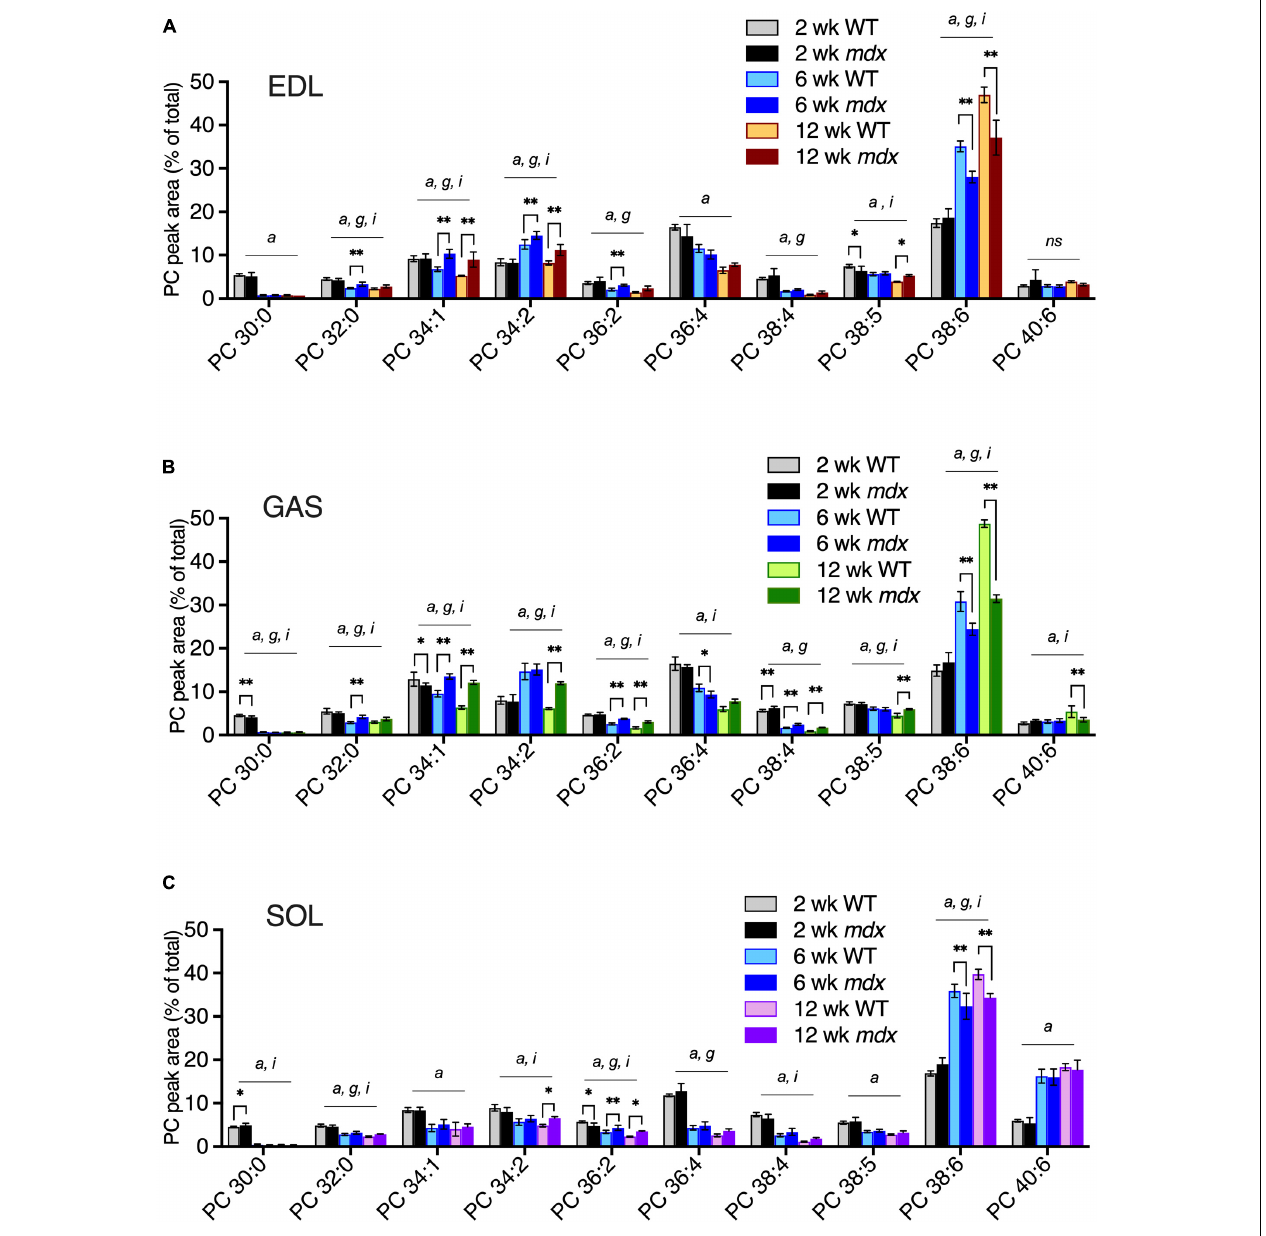
FIGURE 4 | PC alterations in EDL, GAS, and SOL of B10-WT and - mdx mice of various ages ( 2-, 6-, and 12-week-old) were raised on CE-2 standard chow. EDL (A) and GAS (B) showed similar patterns of mdx -associated PC alterations for increased PC 34:1 and decreased PC 38:6 at ages 6- and 12-weeks, and increased PC 34:2 at age 12-weeks, as well as at age 6-weeks in EDL. Mdx -associated PC alterations in SOL (C) were diminished or absent in several cases. PC peak values are expressed as the percentage of total signals and means ± SD are plotted. Significant variation ( p < 0.05) was determined by two-way ANOVA and factor effects for each peak are indicated for age ( a ), mdx genotype ( g ), and interactive effects ( i ). Significant pair-wise differences between same-aged WT and mdx muscles were determined by Sidak’s post-tests; ∗ p < 0.05, ∗∗ p < 0.01. n = 3–6 mice/group. ns ;